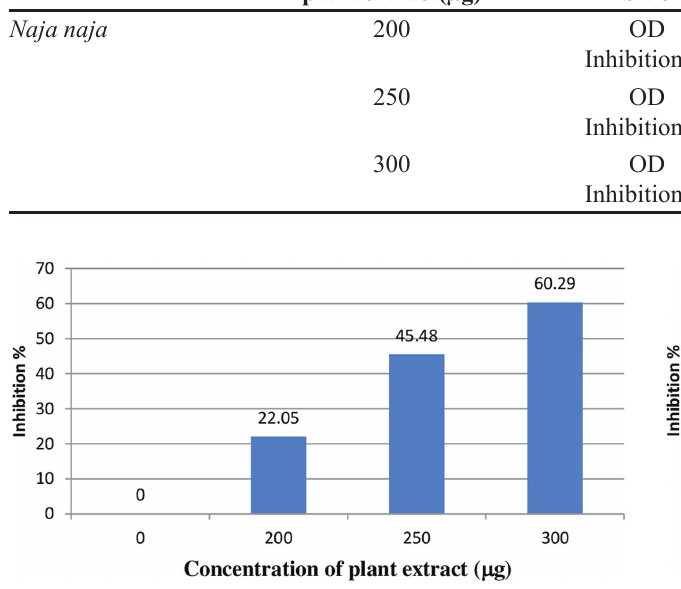
TABLE I - Acetylcholinesterase activity on Naja naja venom Venom sample